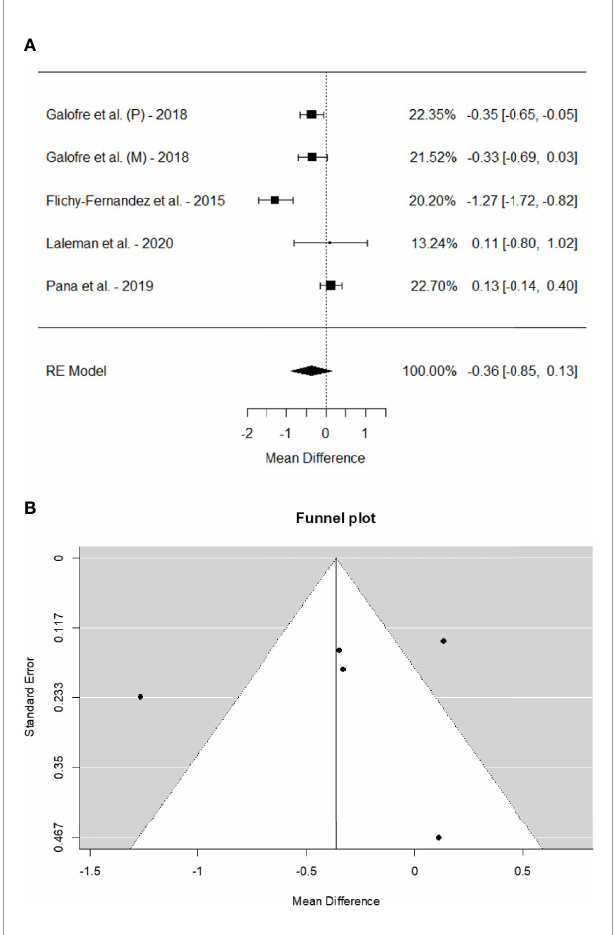
FIGURE 3 | (A) Forest plot on the difference between the test and placebo groups in mean change in probing pocket depth before and after intervention. (B) Funnel plot depicting the publication bias for the studies included in the